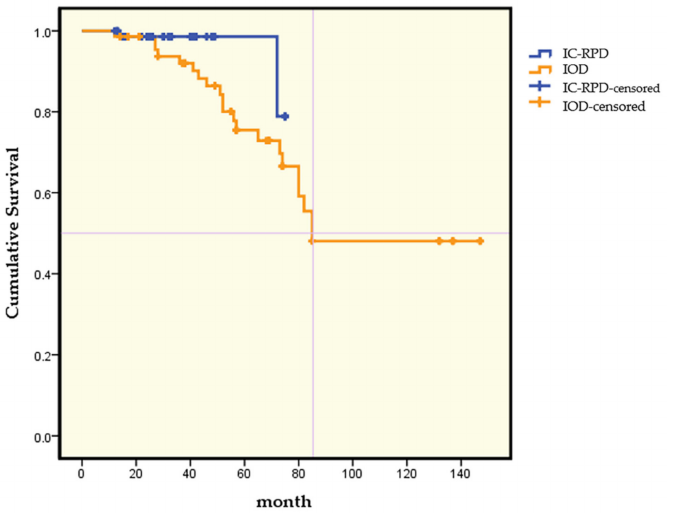
Figure 3. Kaplan–Meier survival curves according to treatment modality (IC-RPD vs.